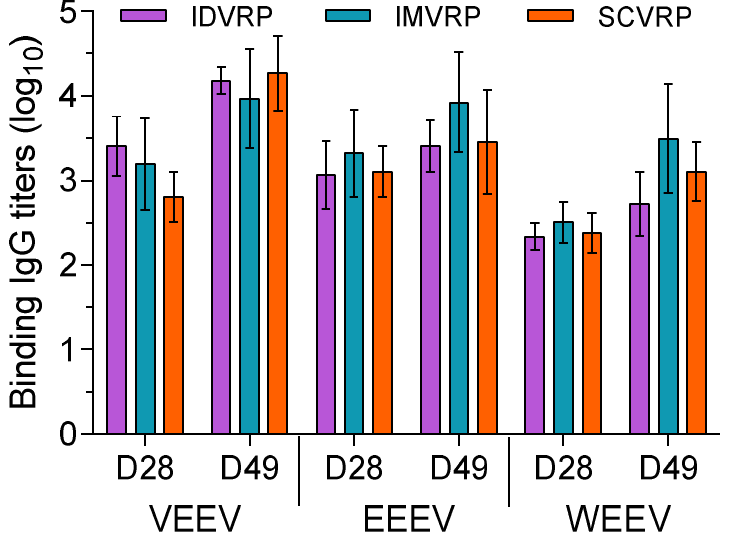
Figure 2. ELISA for sera collected from WEVEE VRP-vaccinated NHPS. Total serum IgG antibody titers were measured from sera collected prior to and on days 28 and 49 after primary vaccination. Binding IgG antibody levels against VEEV, EEEV, and WEEV were assessed. There were no detectable serum neutralizing antibodies in the pre-vaccination or CTRL (PBS) vaccinated NHP sera tested ( n = 7 WEVEE VRP NHPs and n = 6 CTRL NHPs for each challenge virus). Error bars represent ± SD.